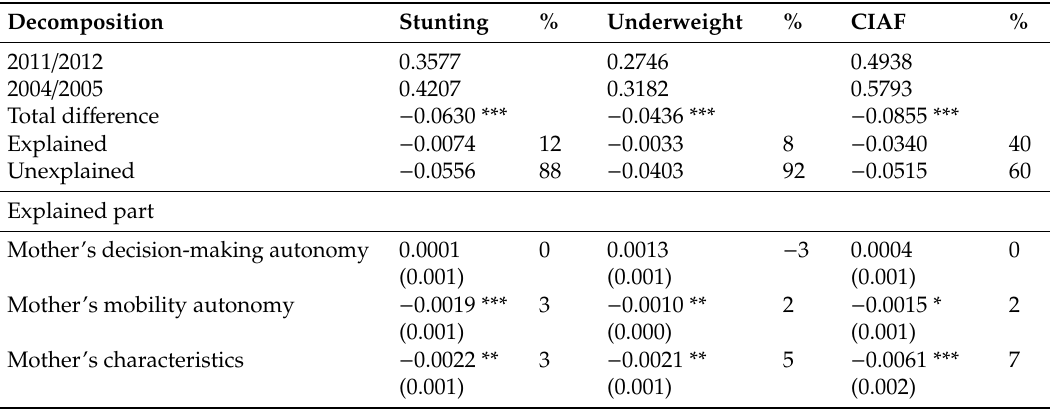
Table 5. Non-linear decomposition of socio-economic di ff erences in stunting, underweight and